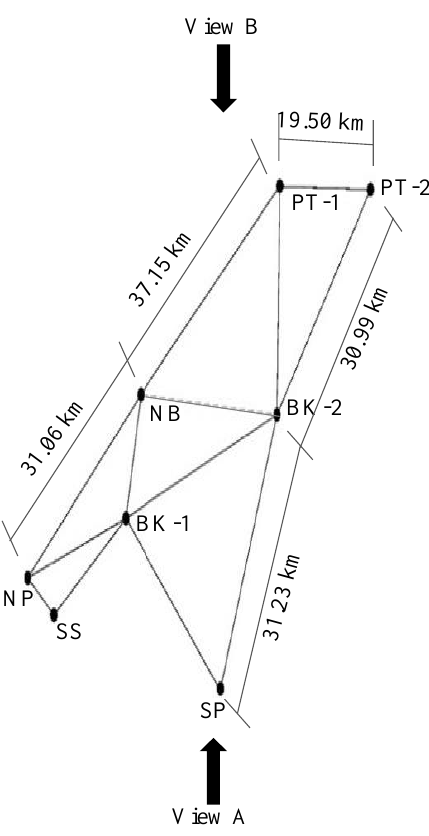
Figure 5. Top view layout of study area.